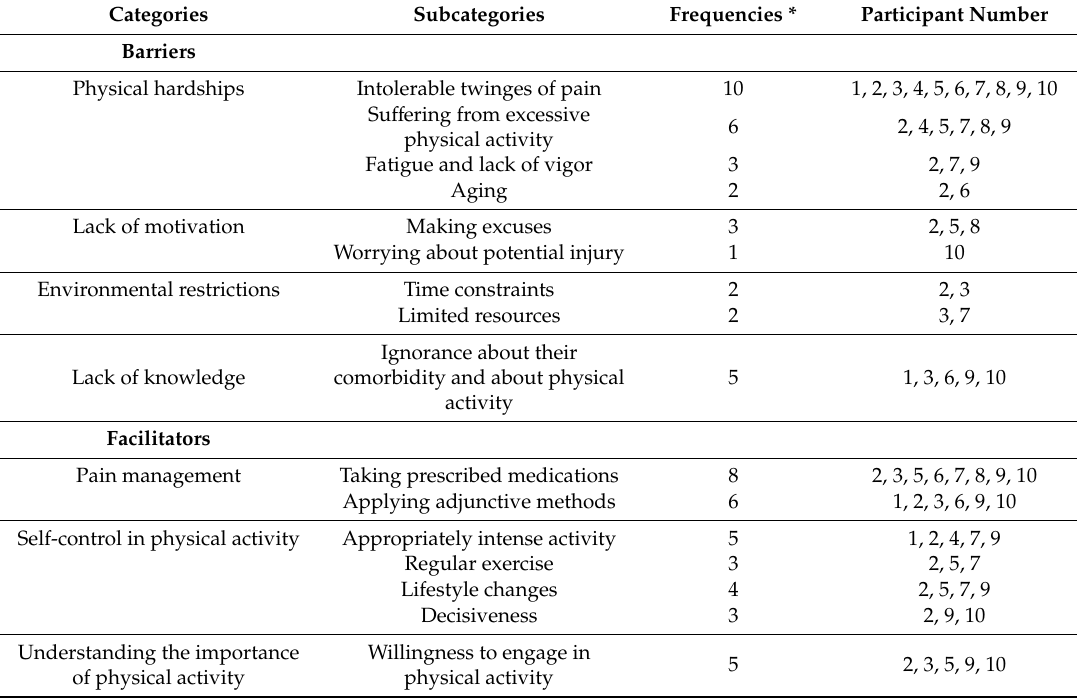
Barriers to and facilitators of physical activity among Korean osteoarthritis adults with